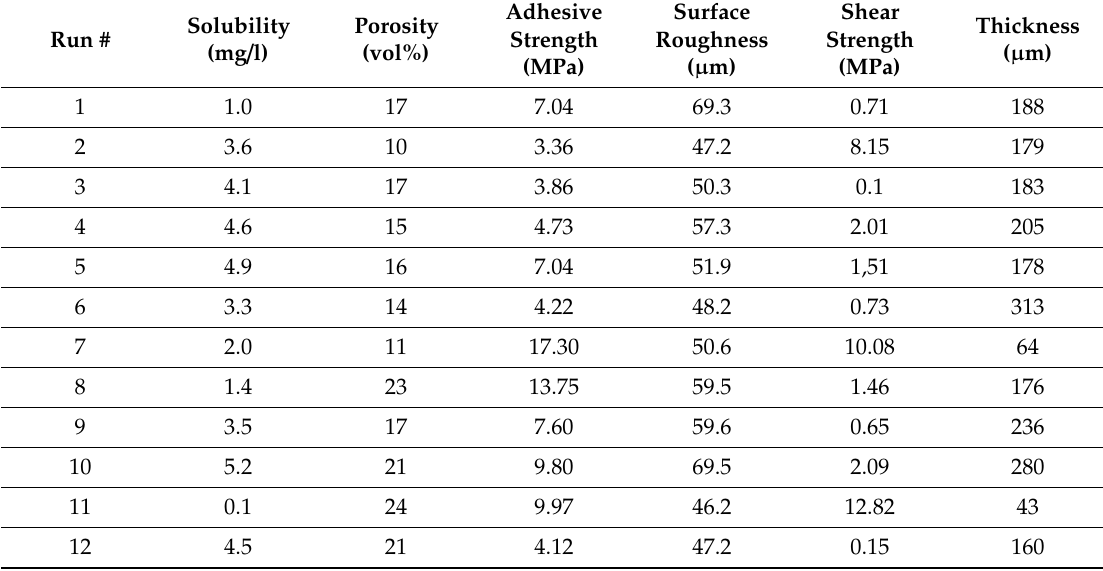
Table 2. Coating properties as functions of the parameter variation